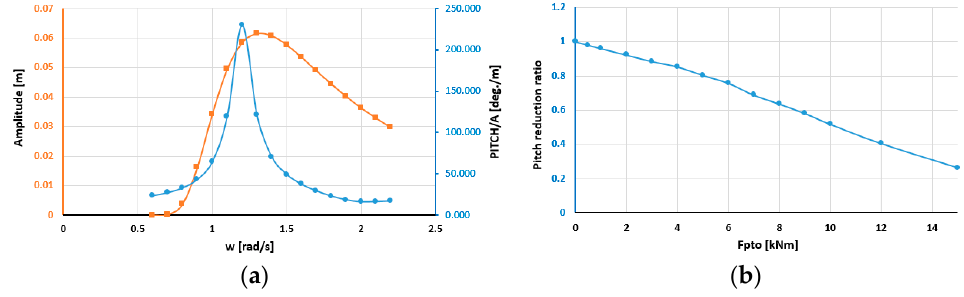
Figure 16. ( a ) Wave spectrum and pitch RAO and ( b ) floating body pitch motion damping ratio according to the PTO force under irregular wave input conditions ( H s = 0.75 m, T p = 4.75